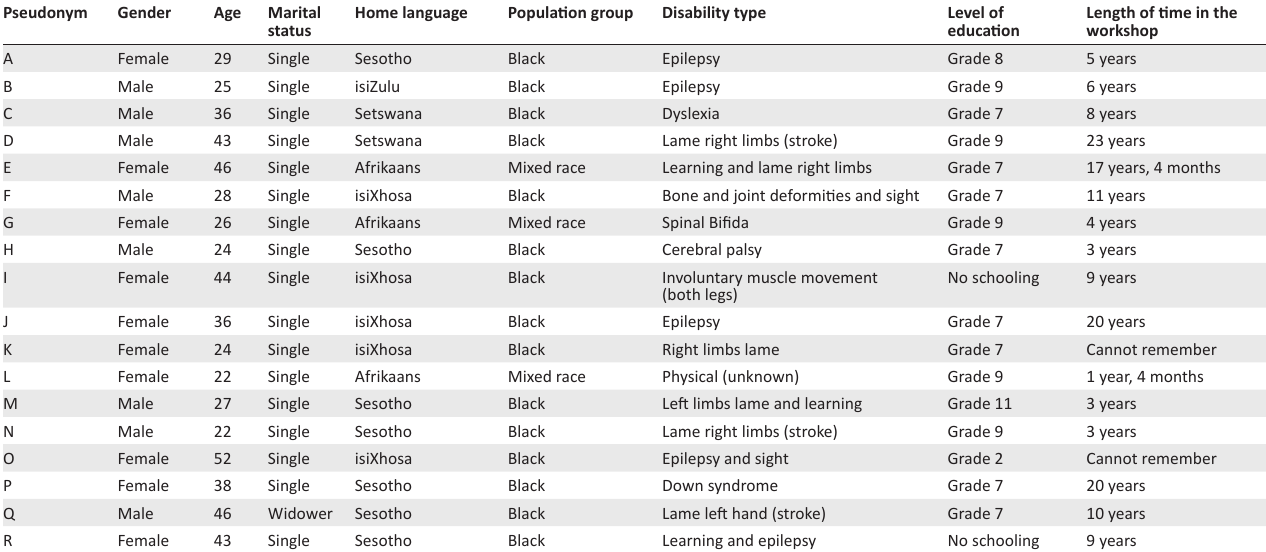
TABLE 1: Demographic profile of the participants.